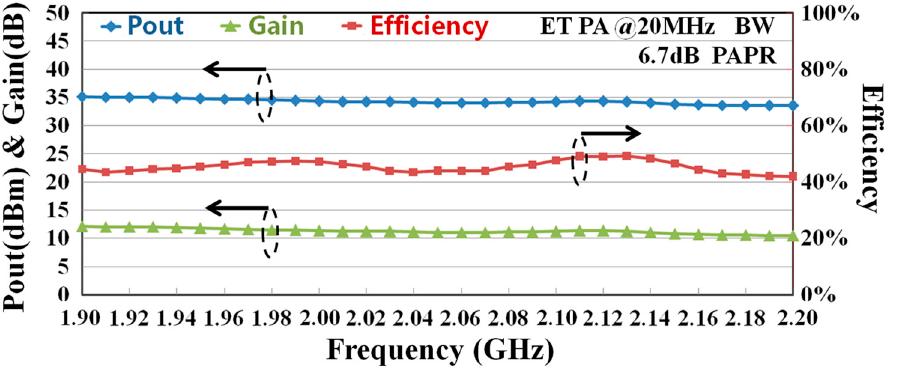
Figure 13. Measured output power, gain, and efficiency of ET PA from 1.9 GHz to 2.2 GHz with 20 MHz BW, 6.7 dB peak-to-average power ratios (PAPR) signals.